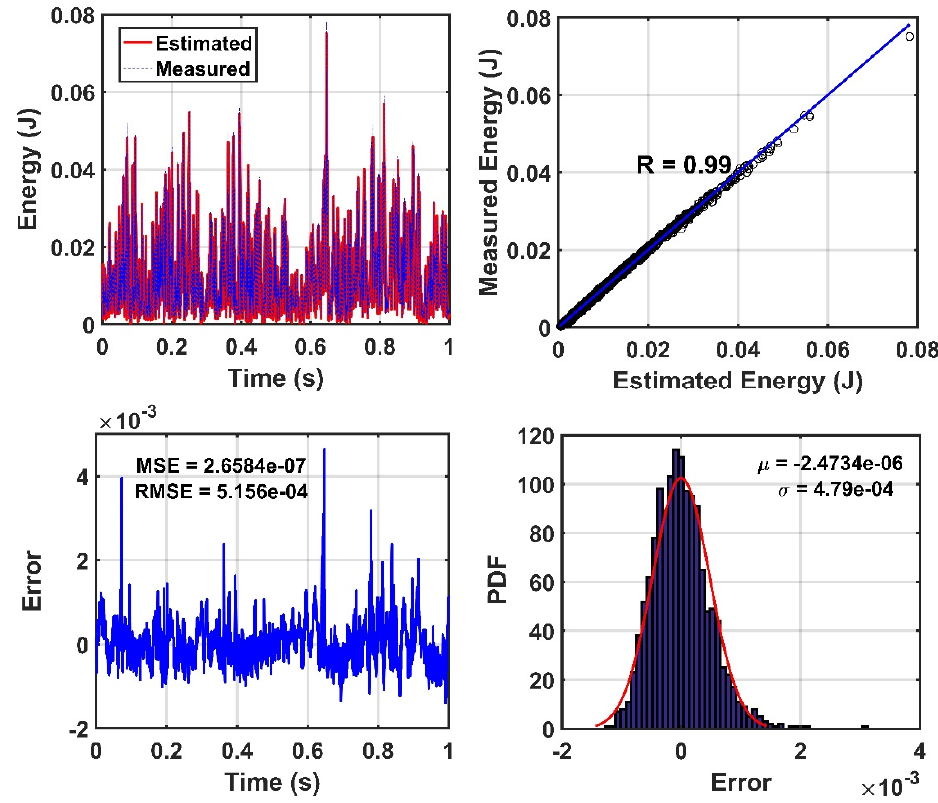
Figure 7. Evaluation of the accuracy performance of training the Artificial Neural Network (ANN) based on the energy parameter of sensor-10 for the healthy state of the truss. (where R , µ , σ , MSE, and RMSE denotes the value of regression, mean, standard division, mean square error, and root mean square error, respectively).